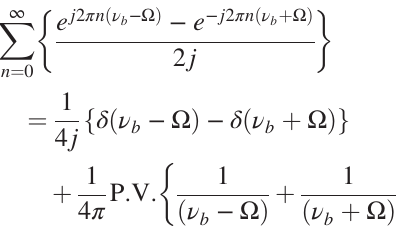
FIG. 4. Growth rate dependence on bunch length C Δ amplitude noise. The LHC nominal bunch length is shown for